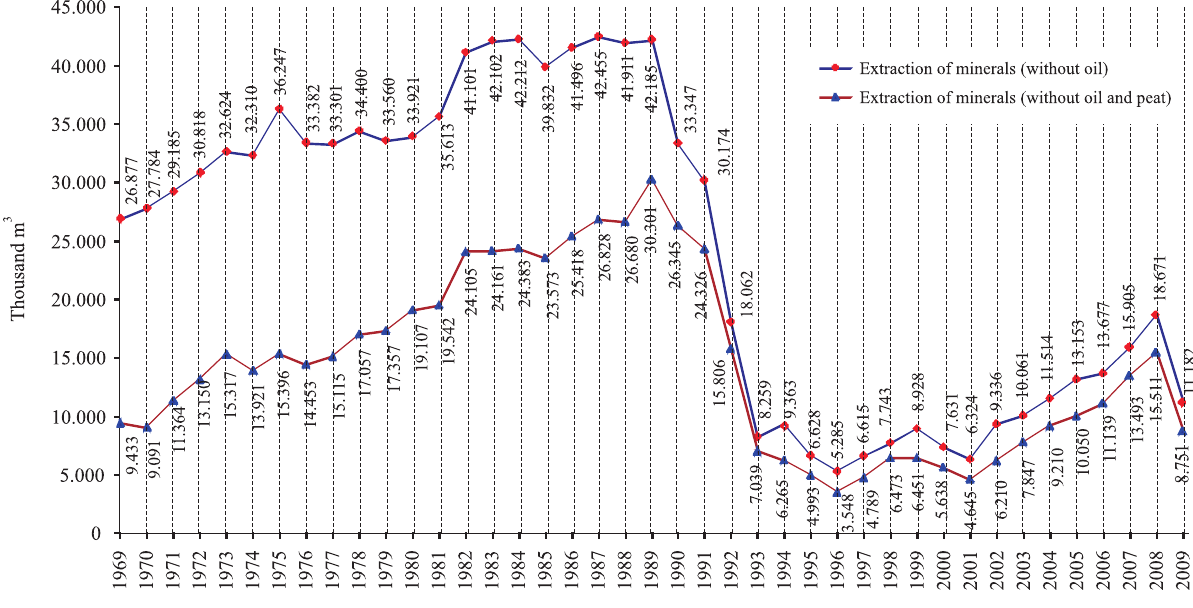
Fig. 2. Total extraction of mineral resources in Lithuania according Lithuanian Geological